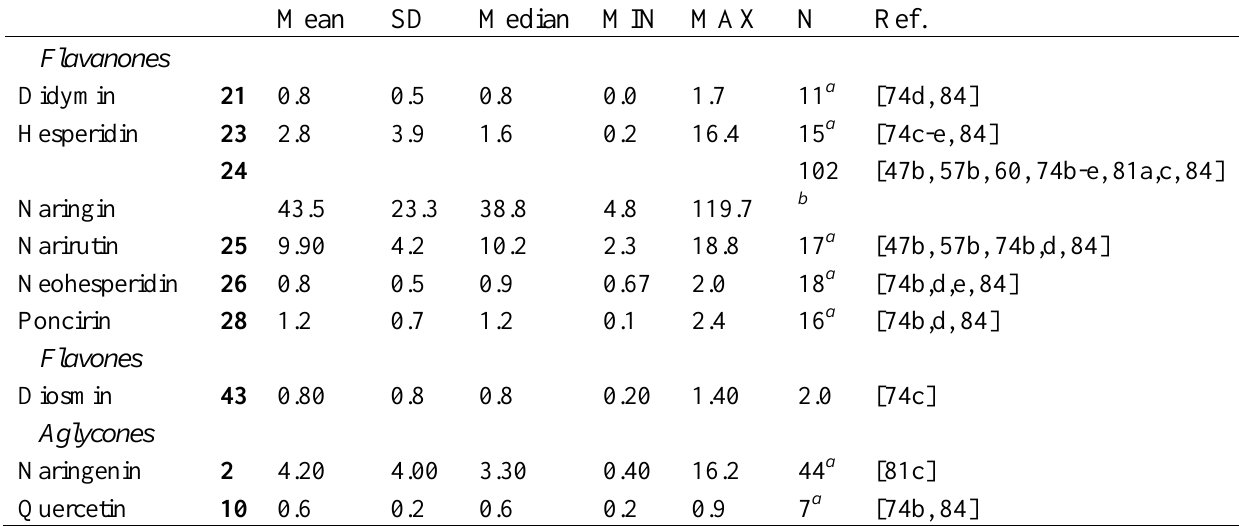
Table 18 . Flavonoid composition of commercial grapefruit juice (mg/100